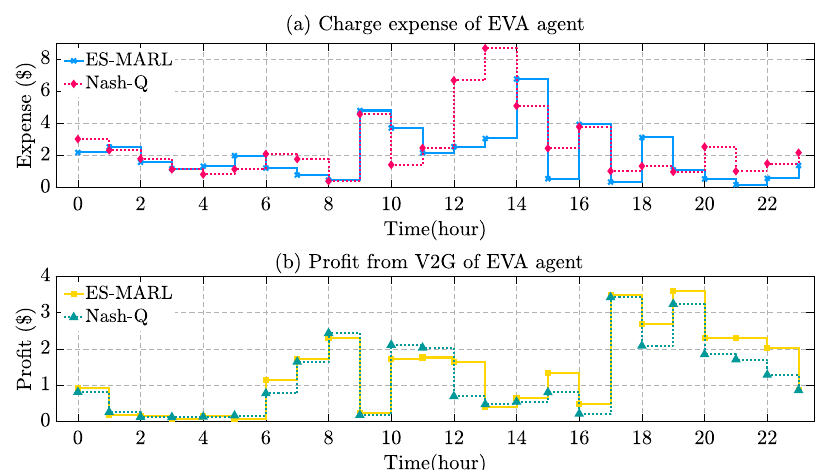
Figure 16. Charge expense and discharge profit of EVA agent with ES-MARL and Nash-Q.